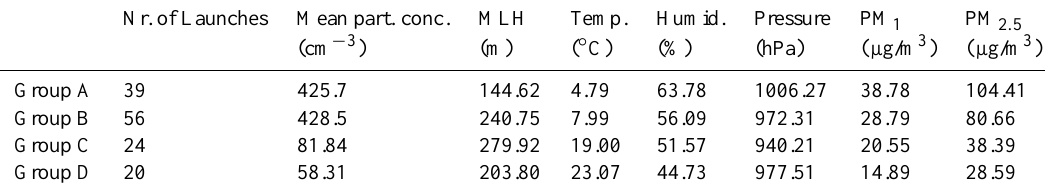
Table 4. Descriptive statistics for each homogeneous group. Nr. of Launches Mean part. conc.